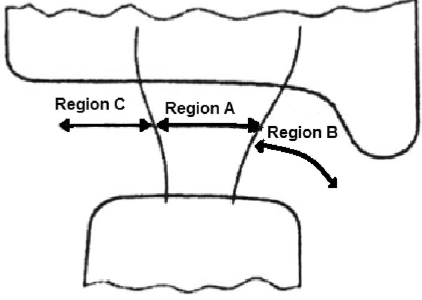
Fig. 2 Contact areas of rail and wheel [25] Fig. 3 Single contact point schematic